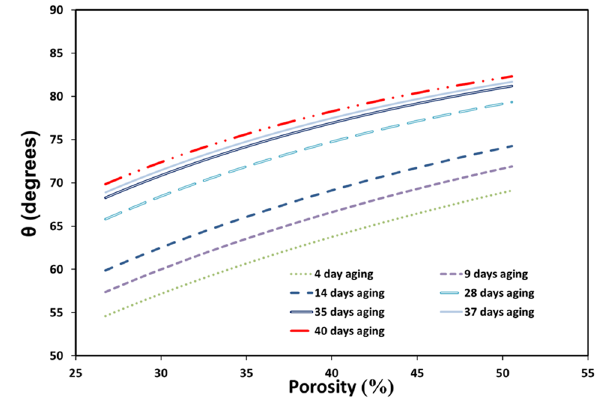
Fig. 7 Relation between the calculated contact angle (using Eqs. 17 and 20) and TVDSS at different porosities